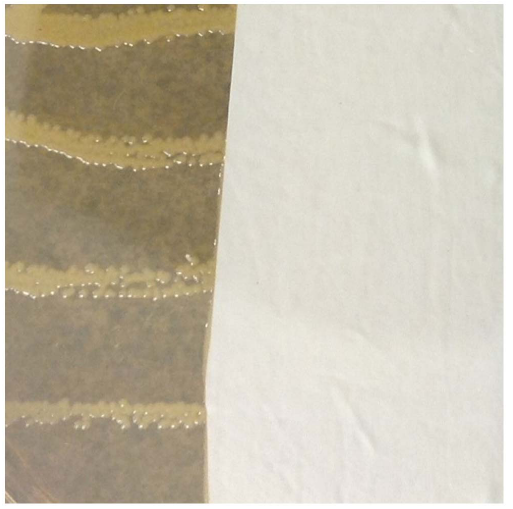
Figure 2. Typical results, nitrile gloves with no inhibition of Staphylococcusaureus demonstrated.